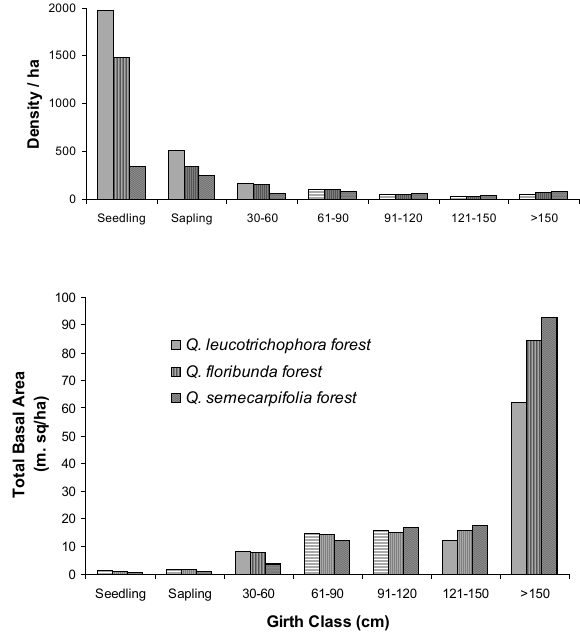
Fig. 3. Distribution of species density and total basal area in dif- ferent girth classes in various oak